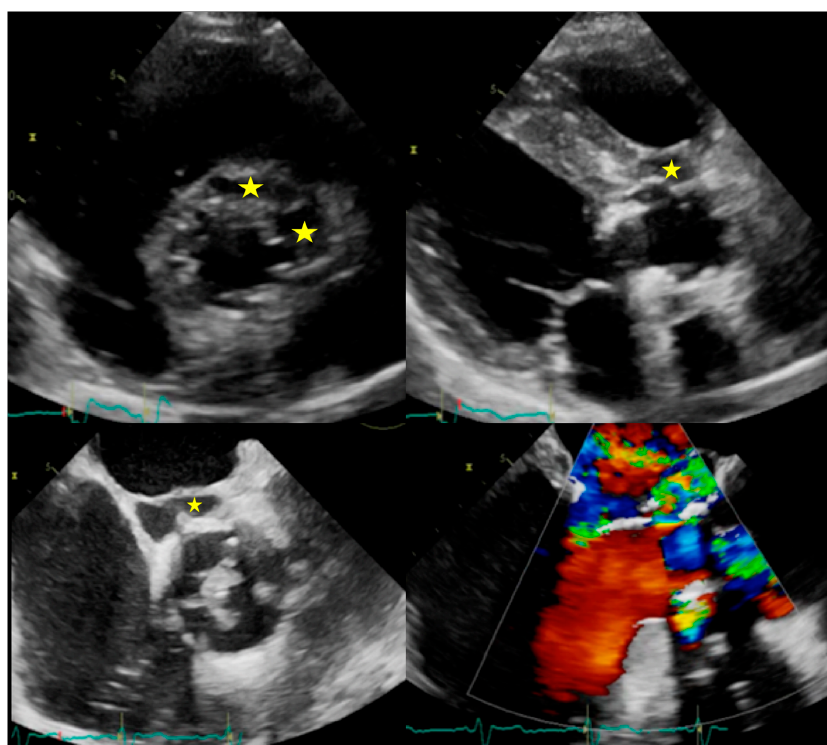
Figure 2. Complications of IE. Top: Example of peri-aortic abscess (stars) with large anechoic cavity surrounding the biological prosthesis (left: TTE with parasternal short axis view, right: TTE with parasternal long axis view). Bottom: Example of peri-aortic pseudoaneurysm (star) with large cavity communicating with cardiovascular lumen (left: TOE short axis view showing large vegetation on prosthesis cusps, right: TOE log axis view with color Doppler showing flow into the perivalvular cavity).